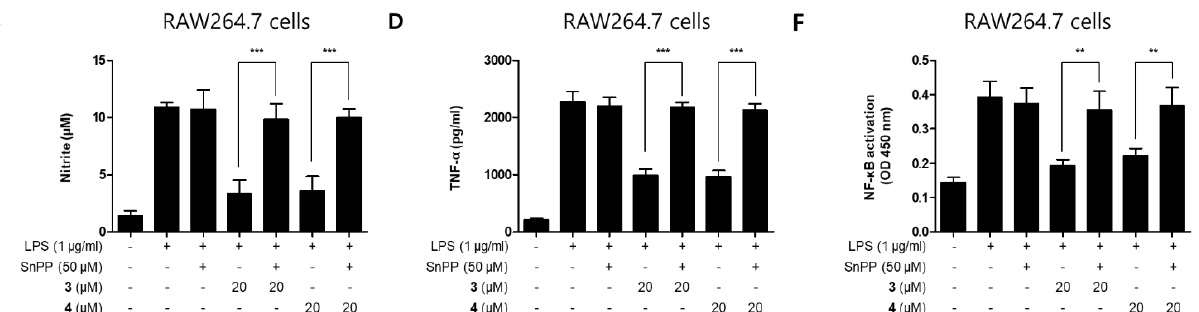
Figure 9. Inhibitory effects of compounds 3 and 4 on nitrite production through the regulation of HO-1 activity in BV2 ( A , C , E ) and RAW264.7 ( B , D , F ) cells. The cells were treated with 50 µ M of tin protoporphyrin-IX (SnPP) or compounds 3 or 4 and stimulated for 24 h with lipopolysaccharide (LPS; 1 µ g/mL). Data are presented as mean ± standard deviation of three independent experiments. ** p < 0.01 and *** p < 0.001.